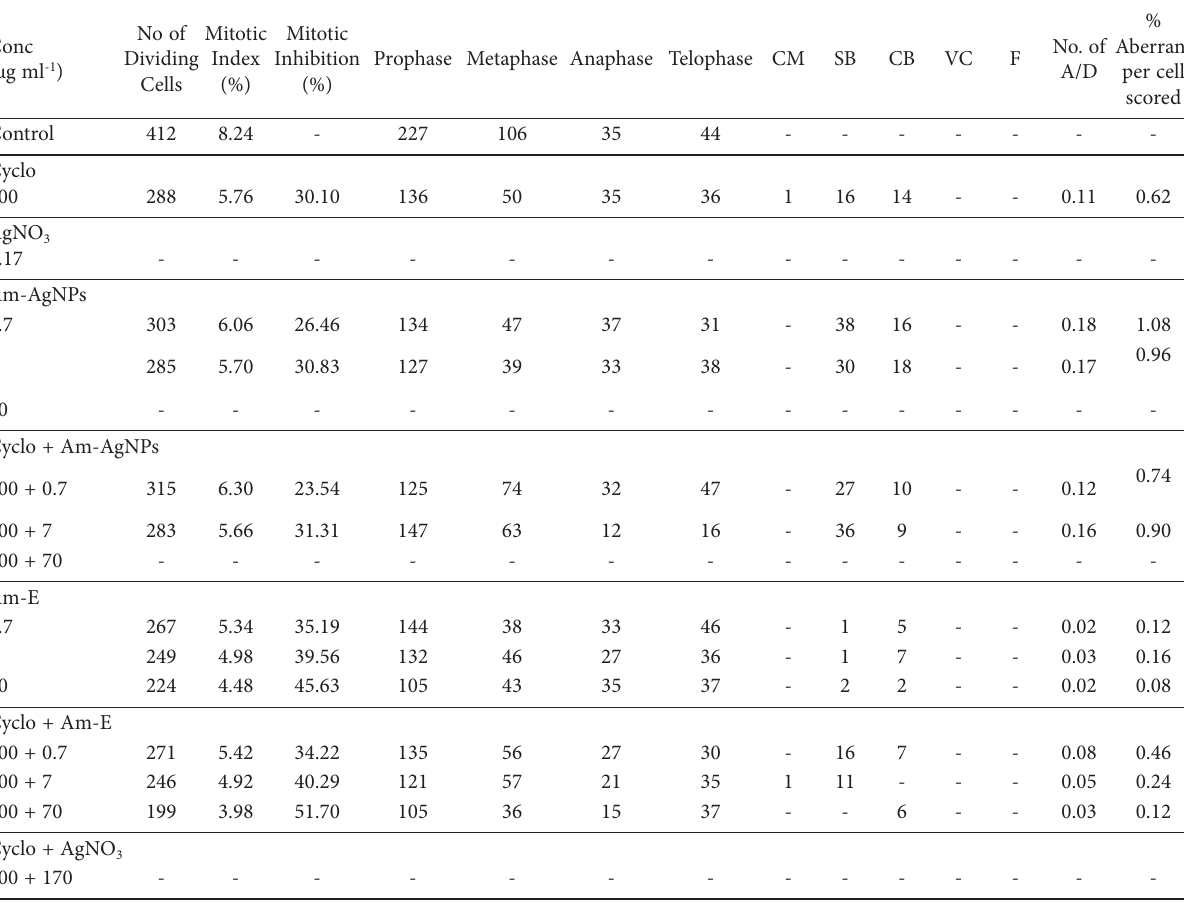
Table 4. Cytogenotoxic Effect of A. muricata Extract-Mediated Silver Nanoparticles on Allium cepa roots meristerimatic cells at 48 h com- pared with control (positive and